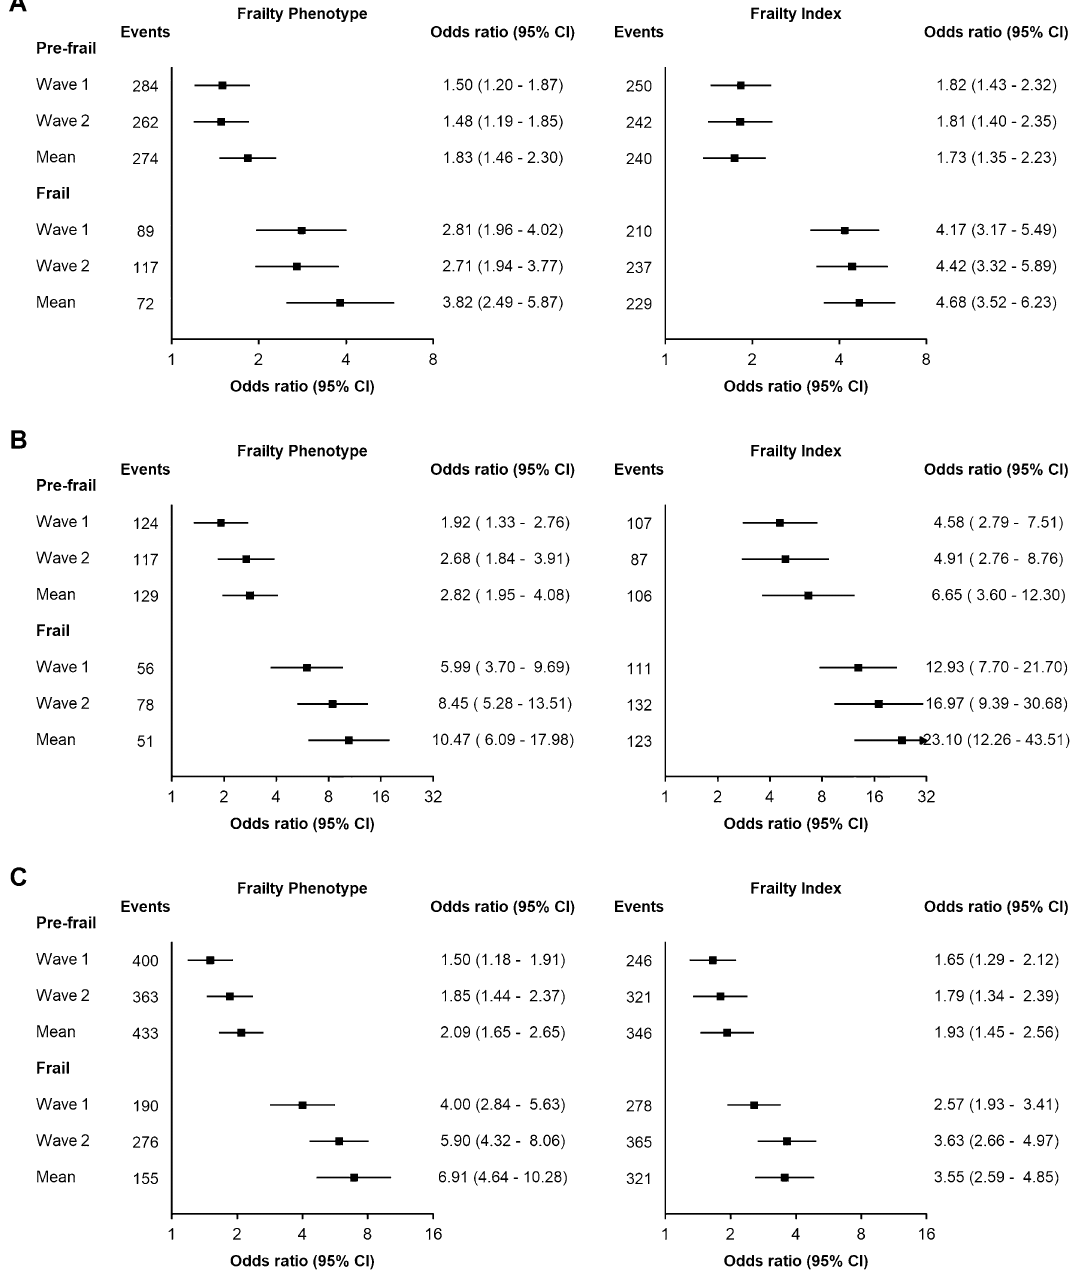
adverse health outcomes. For the FP, the combined mean score had a twofold greater strength of association than baseline values alone with higher AUCs. Hence, in settings where electronic records are widely used it should be relatively simple to implement an assessment of frailty using measurements recorded at multiple time points. Attention to detail about within-person variability in frailty measures and comparative performance of different instruments to quantify frailty is important when assessing the determinants of frailty or prognosis following a diagnosis of frailty in population studies and in clinical practice. The present study also provides support for an emerging consensus that different frailty instruments measure different constructs 47 . FP measures a progressive state of low energy, sarcopenia and low strength 48 , but FI measures the loss of physiological reserve through lower redundancy 49 , and hence it may be prudent not to use these different measures interchangeably.